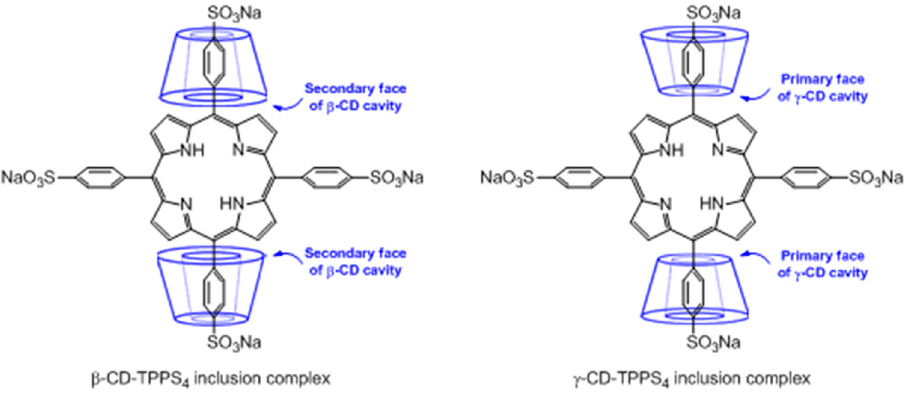
Figure 5. Two examples of typical geometry adopted by CD–PS inclusion complexes between β